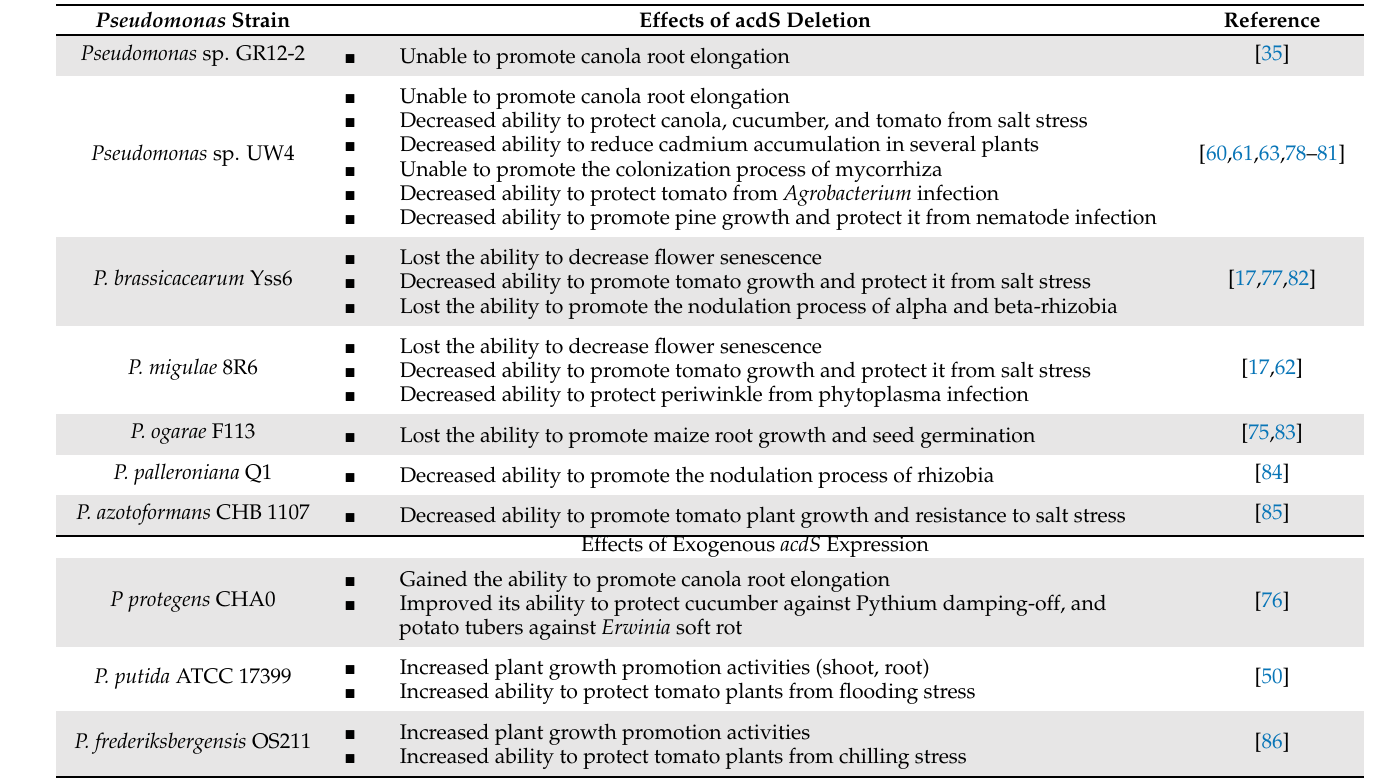
Table 3. Studies on the role of ACC deaminase ( acdS gene expression) in different Pseudomonas strains. Pseudomonas Strain Effects of acdS Deletion Pseudomonas sp.